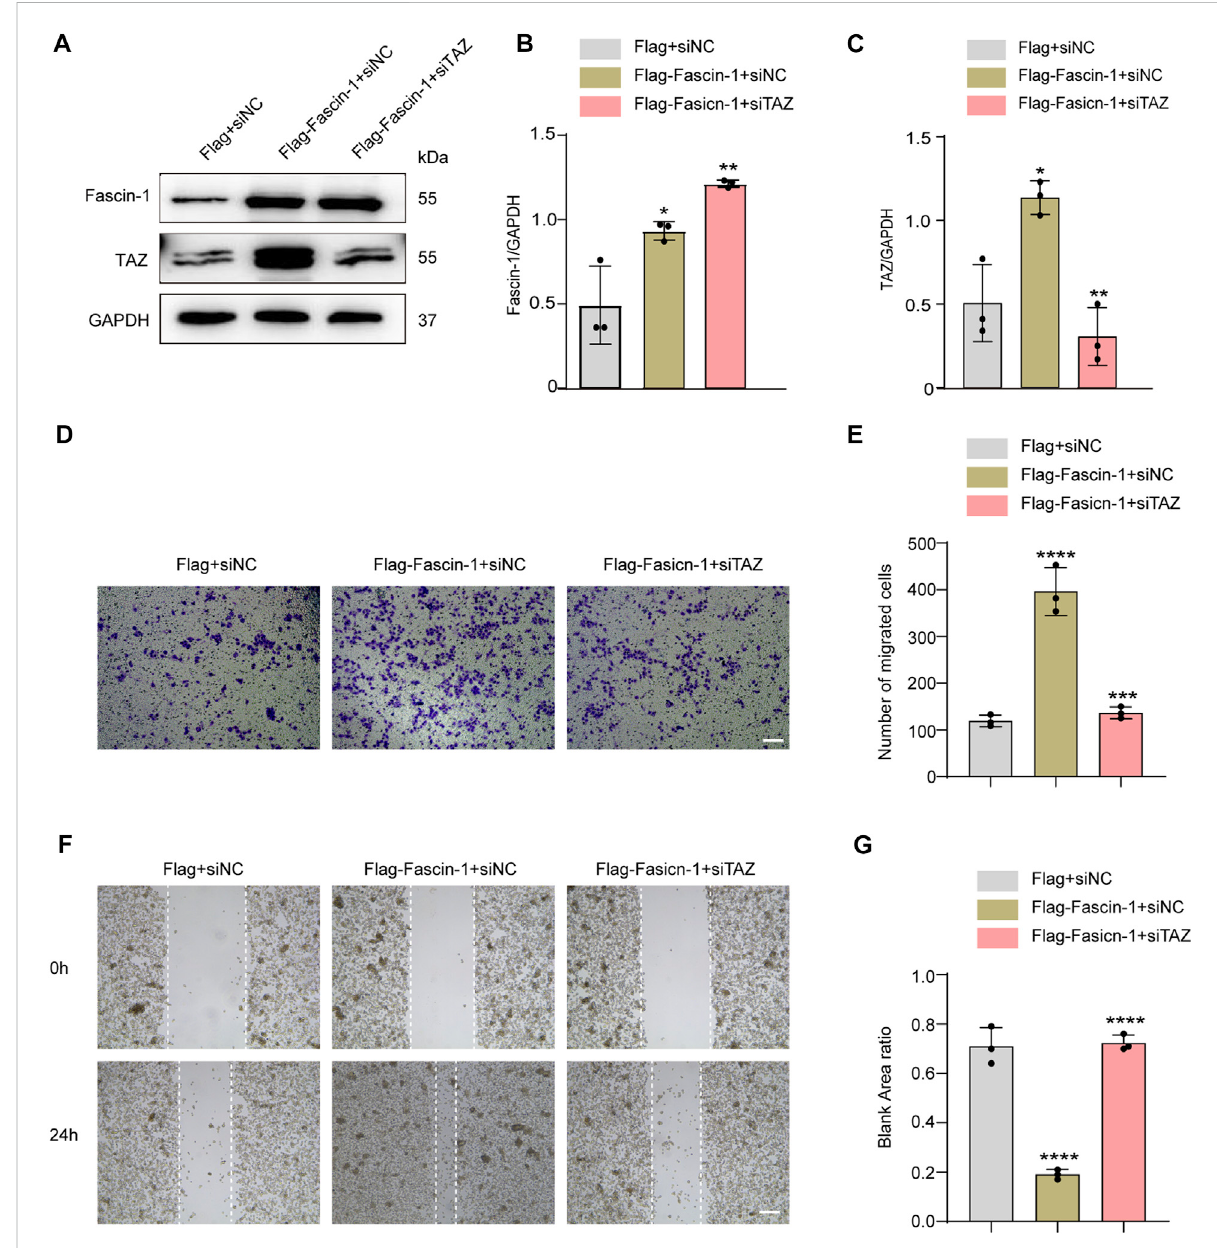
FIGURE 8 TAZwasdownstreamofFascin-1forregulatingmicroglialmigration. (A) WesternblotwasusedtodetectproteinexpressionchangesofFascin- 1 and TAZ after different treatment groups, including Flag+siNC, Flag-Fascin-1+siNC, Flag-Fascin-1+siTAZ ( n = 3 per group). (B,C) Quantitative analysis of the relative levels of Fascin-1 (B) and TAZ (C) as shown in (A) . The protein expression was normalized to GAPDH. Data were mean ± SEM. * p < 0.05(Flag-Fascin-1+siNCvs.Flag+siNC);** p < 0.01(Flag-Fascin-1+siTAZvs.Flag-Fascin-1+siNC)in (B,C) . (D,F) ScratchandTranswelltests wereused to detect microglial migration in theabove treatment groups( n =3 per group). (E) Quantitative analysis ofthenumber oftransmembrane cells in (D) . Data were mean ± SEM. **** p < 0.0001 (Flag-Fascin-1+siNC vs. Flag+siNC), *** p < 0.001 (Flag-Fascin-1+siTAZ vs. Flag-Fascin-1+siNC). Scale bar: 200 μ m. (G) Quanti fi cation of blank area ratio in (F) . Data were mean ± SEM. **** p < 0.0001 (Flag-Fascin-1+siNC vs. Flag+siNC), **** p